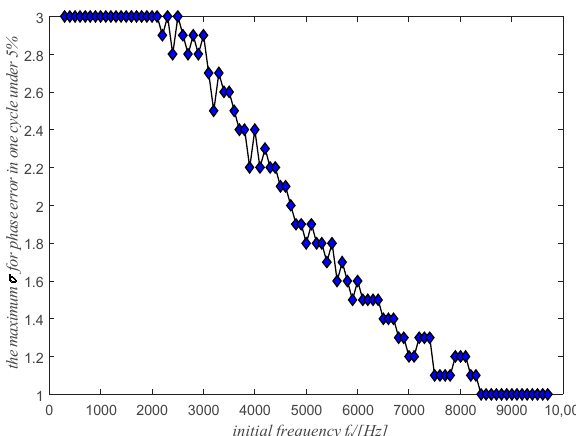
Figure 9. The maximum σ for the di ff erent initial frequency f 0 with the maximum phase error in one cycle under 5%.